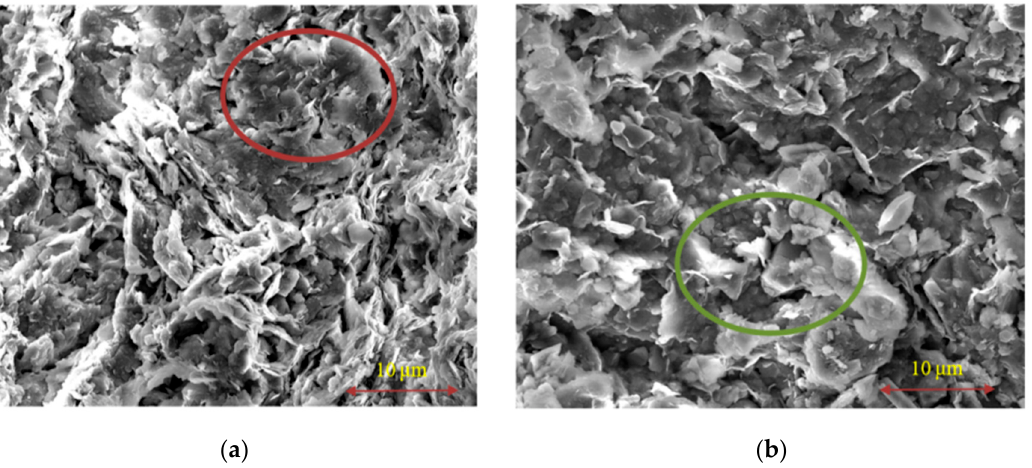
Figure 8. SEM image: ( a ) one cycle frozen soil at − 10 °C; ( b ) second cycle frozen soil at − 10 °C.